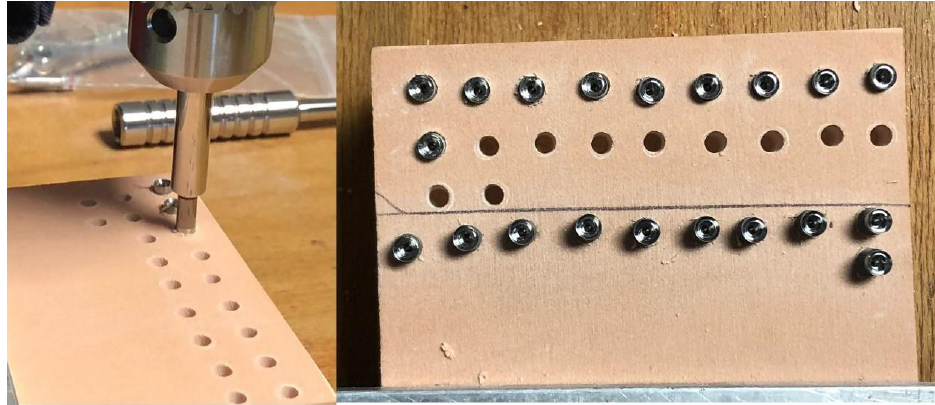
Figure 7. In detail, the phases of implant positioning into the polyurethane block.